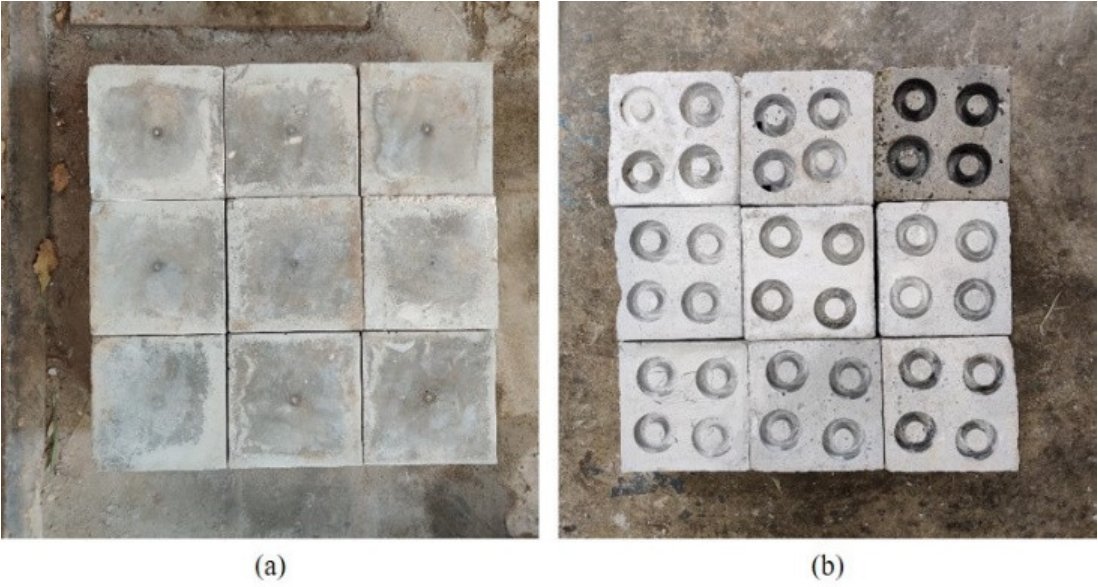
Figure 9. ( a ) The rock samples before the experiment and ( b ) rock samples after drilling.